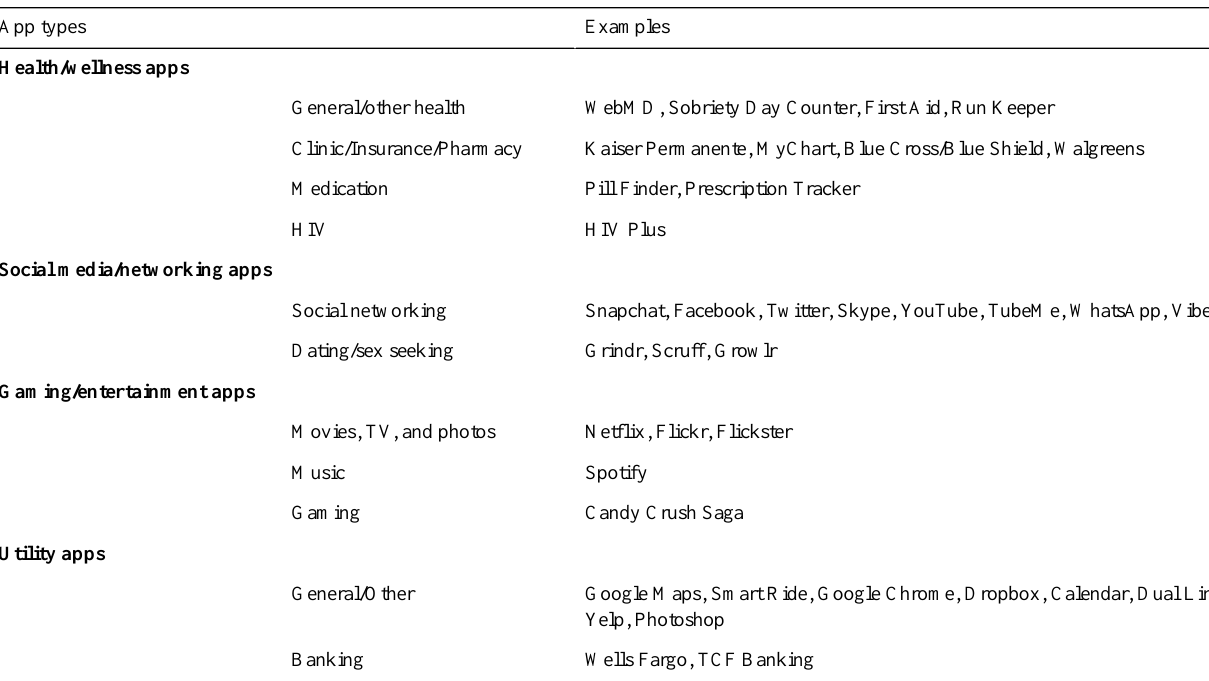
Table 2. Types of apps downloaded by